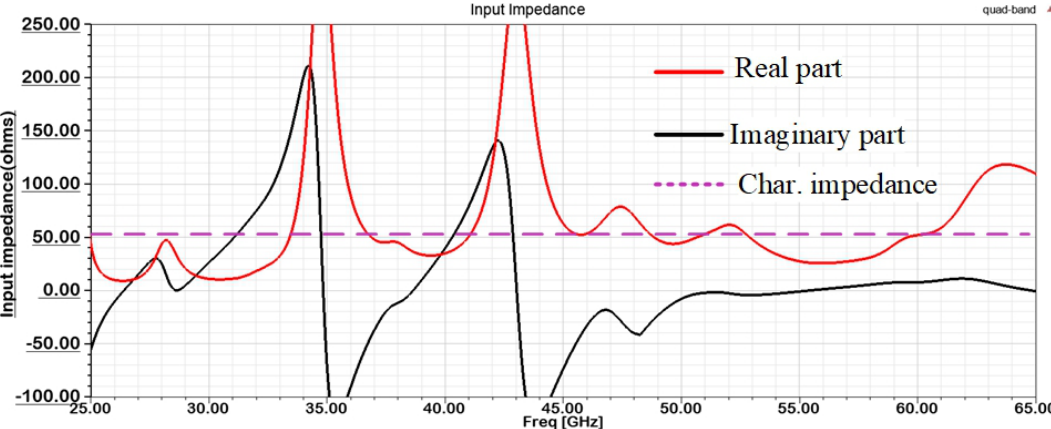
Figure 6. Real and imaginary input impedance plot versus